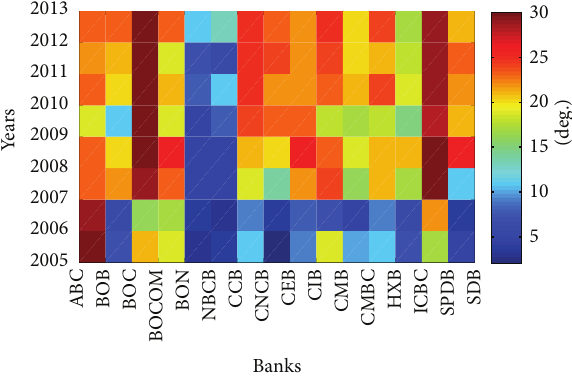
Figure 4: Color code representation of the time evolution of the degree of each banks observed in the networks of the Chinese interbank market computed by using a 1-year evaluation time